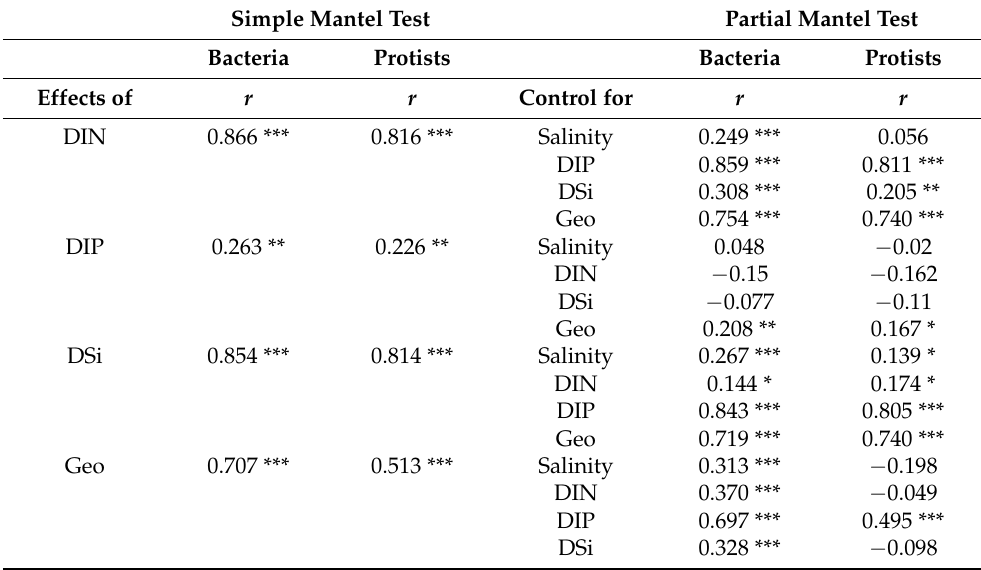
Table 1. Simple and partial Mantel tests for the correlations between bacterial/protistan community dissimilarity and salinity, DIN, DSi and geographical distances based on Spearman rank correlation coefficient. DIN, dissolved inorganic nitrogen; DSi, dissolved silica; Geo, geographical distance. The significance was tested based on 9999 permutations, and p value < 0.05 was considered as a significant effect (* p < 0.05; ** p < 0.01; *** p < 0.001). Simple Mantel Test Partial Mantel Test Bacteria Protists Bacteria Protists Effects of r r Control for r r DIN 0.866 *** 0.816 *** Salinity 0.249